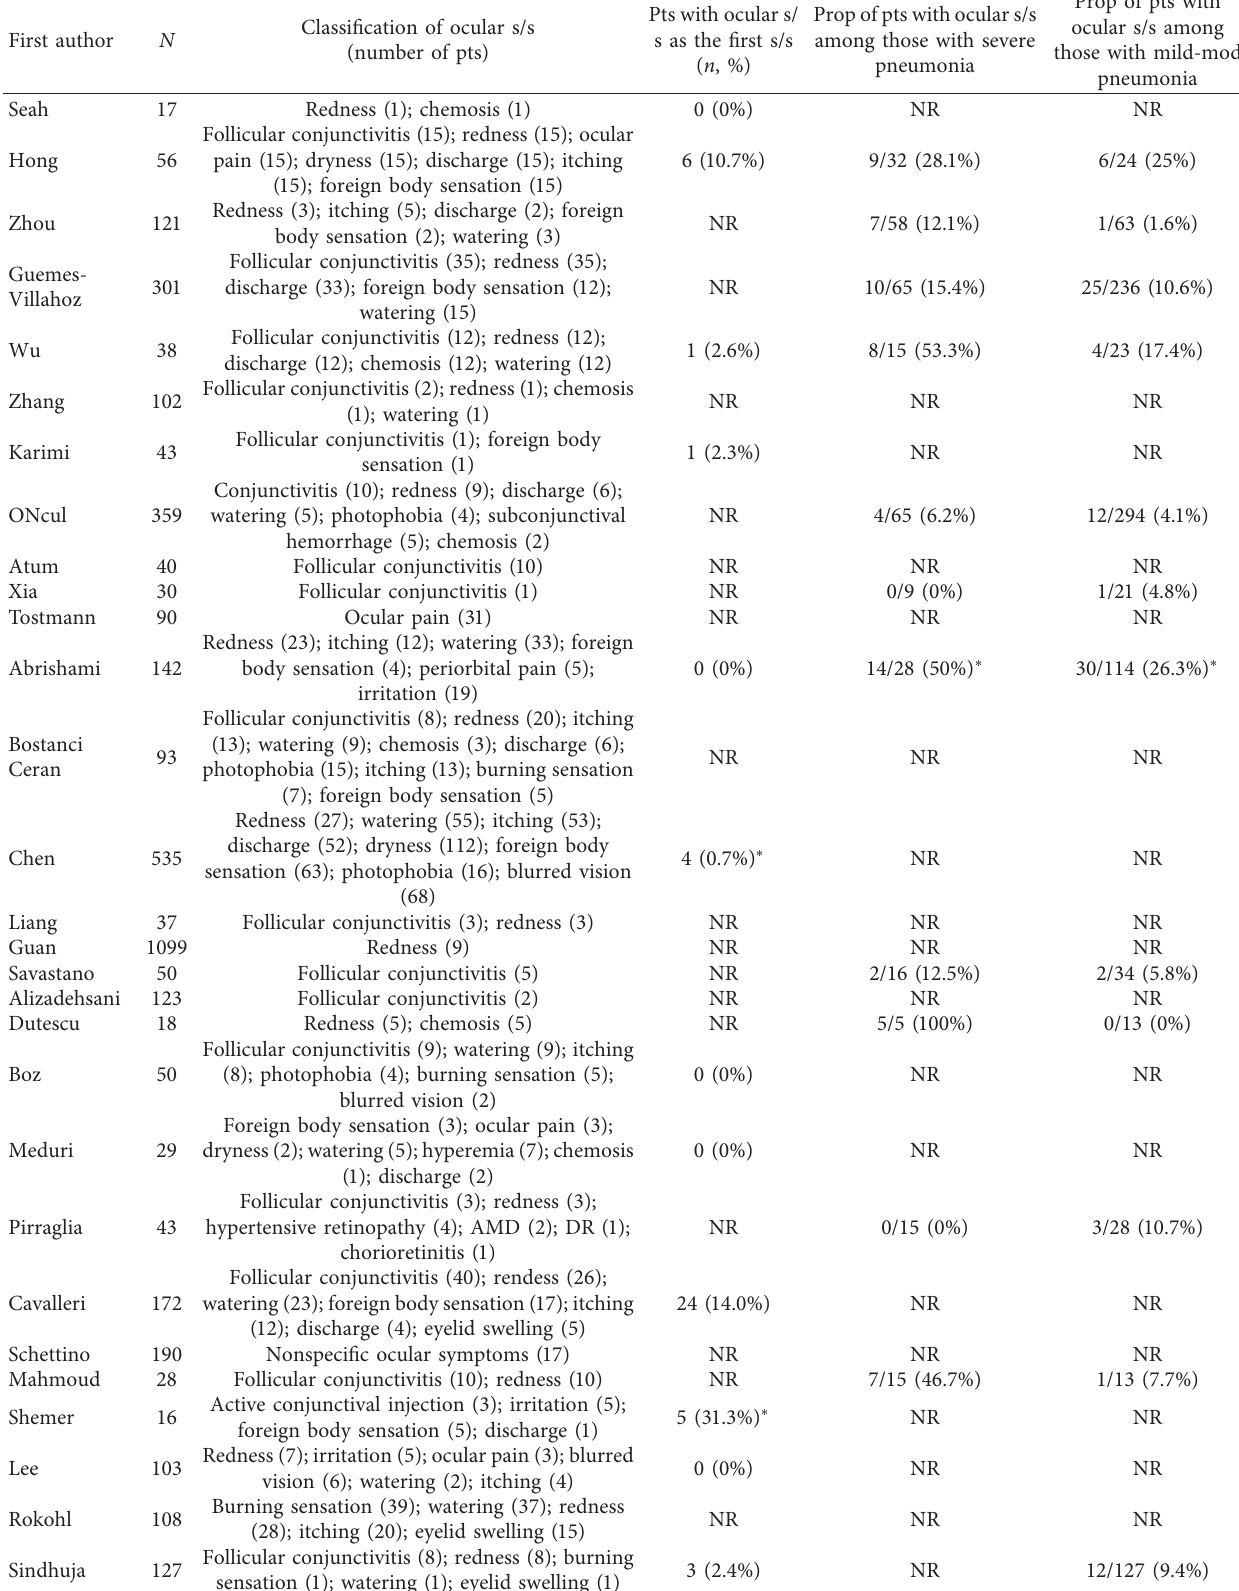
Table 3: Clinical features of ocular manifestations among COVID-19